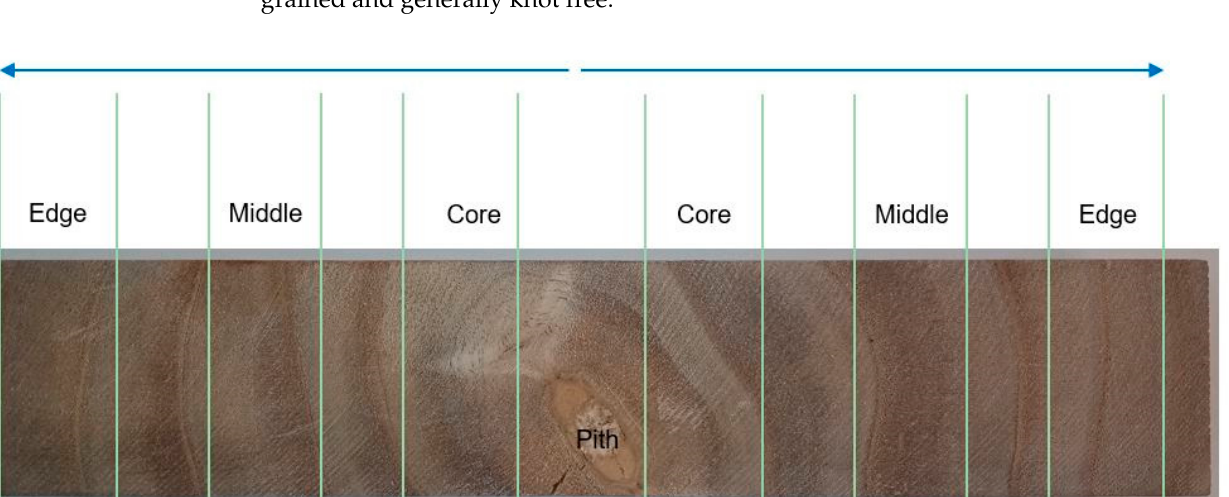
Figure 4. Two spots on the Paulownia stem (0–1 m and 4.5–6 m) selected after harvesting for the research investigation.